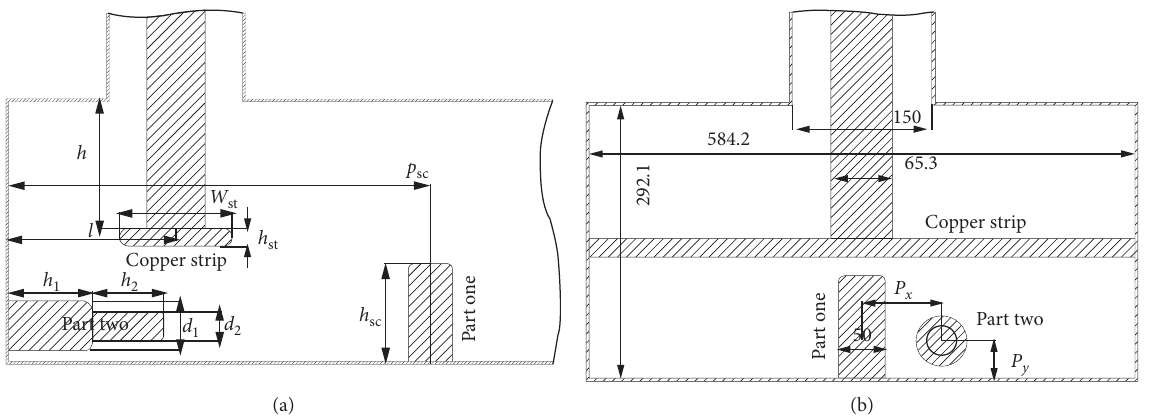
Figure 2: Structure with all designed parameters (a) side view and (b) front view.